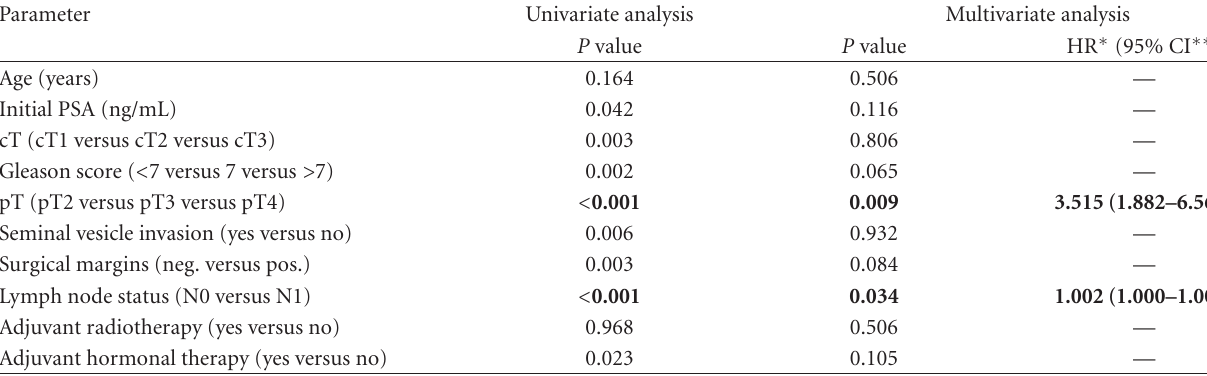
Table 4: Univariate and multivariate analysis of pathologic variables.